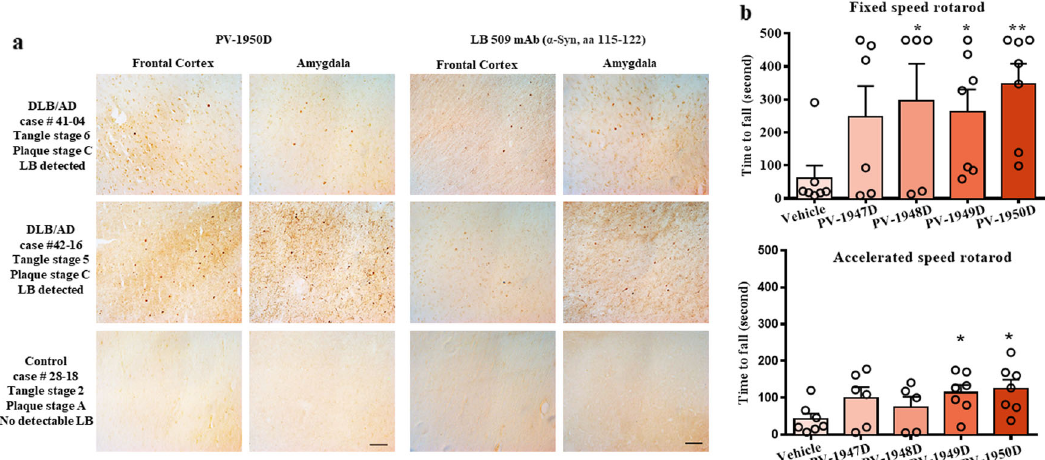
Fig. 2 Anti-h α -Syn antibodies induced by PV-1950 recognized LBs in the brains from DLB/AD cases and improve motor function of h α - Syn/Tg D line mice. a Representative images of the frontal cortex and amygdala sections from two DLB/AD cases stained with antibodies generated by PV-1950D and anti- α Syn commercial antibodies LB509. Magni fi cation ×20, scale bar 50 μ m. b Motor skills of female mice were tested in Fixed speed rotarod and accelerated speed rotarod. Statistical signi fi cance is calculated using an unpaired t -test. Due to high body weight and clumsiness, male mice were excluded from the behavior tests. Error bars indicate the mean values ±